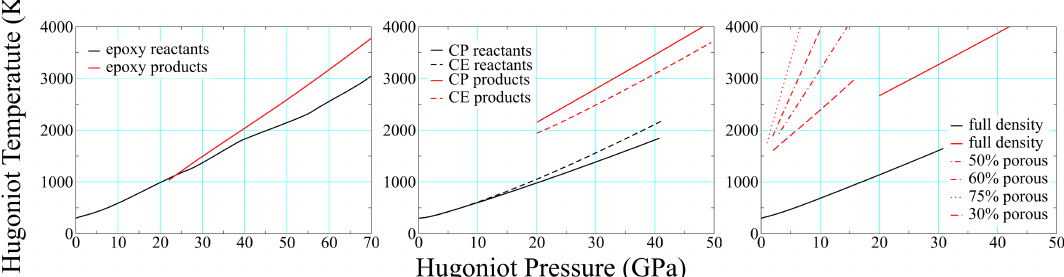
Figure 11. Reactant and product temperatures for epoxy ( left ), CP and CE composites ( center ), and both porous and solid-density PMDI polyurethane ( right ). All reactant curves are black, product curves are red; only the full-density reactant curve is shown for polyurethane.